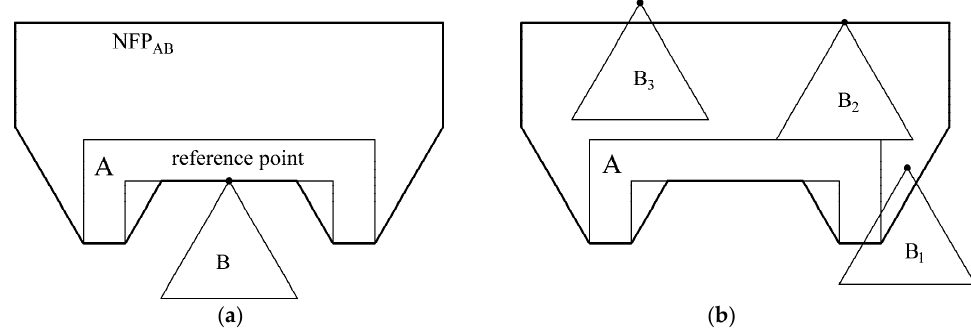
Figure 1. ( a ) Polygons A , B and construction of NFP AB and ( b ) The properties of the no-fit polygon.